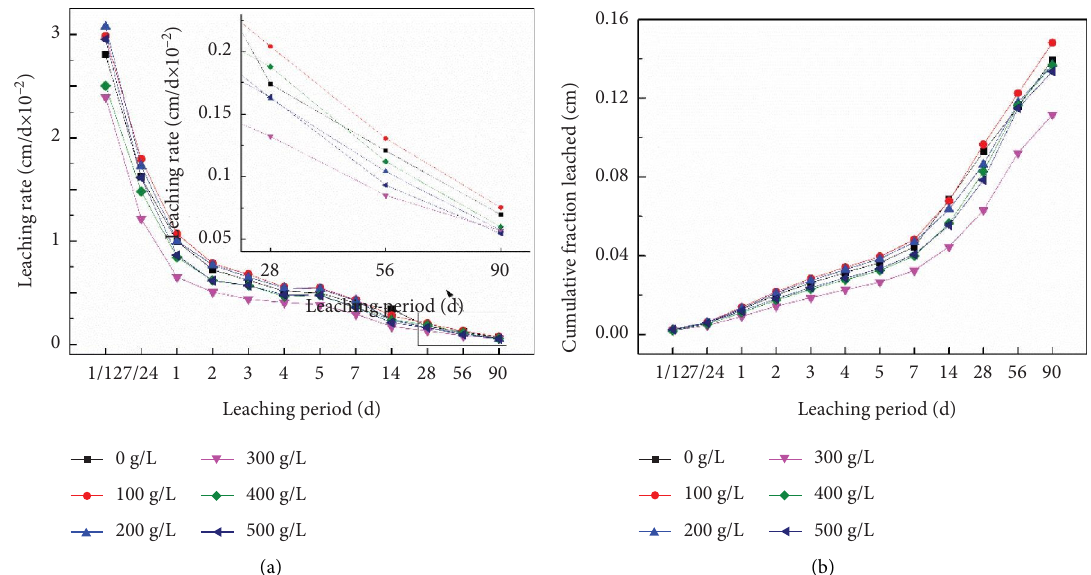
Figure 18: Te leaching curves of Sr 2+ in the SFCM containing diferent concentrations of sodium nitrate at a sodium hydroxide content of 5%: (a) LF; (b) CLF.